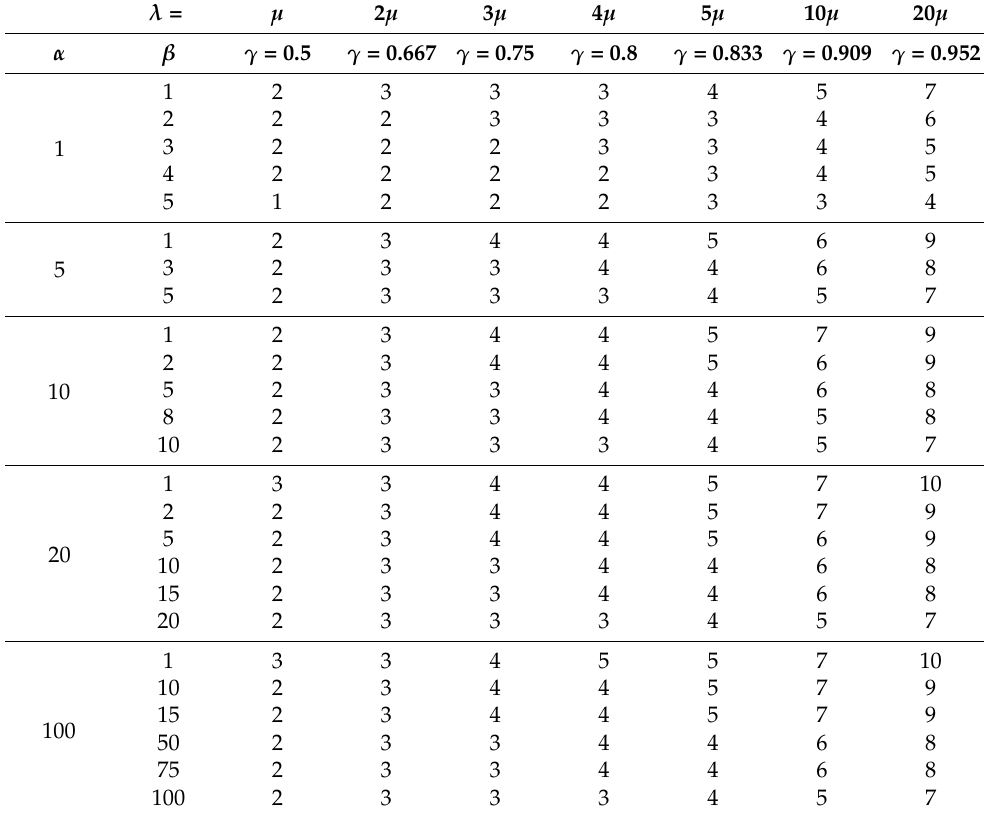
where X 0 = 1 and k = 0, 1,2, . . . . In Table 1, the optimal values X* are given for different α , β , and γ , where λ = z µ , and z = 1, 2, 3, 4, 5, 10, 20, and determined according to different combinations of α and β values. We assumed that the values of ( β ) were {1, 2, 3, 4, 5, 10, 15, 20, 75, 100} and the values of α were {1, 5, 10, 20, 100}. Clearly, the value of X* increased when the ratio ( γ ) increased (i.e., λ increased), and X* increased slightly with the large increase in α values for any specific fixed value of the request ratio ( γ ). On the other hand, X* decreased when ( β ) increased. However, the results of Table 1 confirmed the consistency of the relation between the optimal value C ( m ), α , β and γ that were previously deduced. In this context, the main factors that increased the authentication requests were the medical status and the number of the patient’s connected sensors. Table 1. The optimized X* of the cost function C( m ) for different values of ( α ) and ( β ) with respect to a fixed ratio ( γ ) when λ = z µ , where z = 1, 2, 3, 4, 5, 10, and 20. λ = µ 2 µ 3 µ 4 µ α β γ =